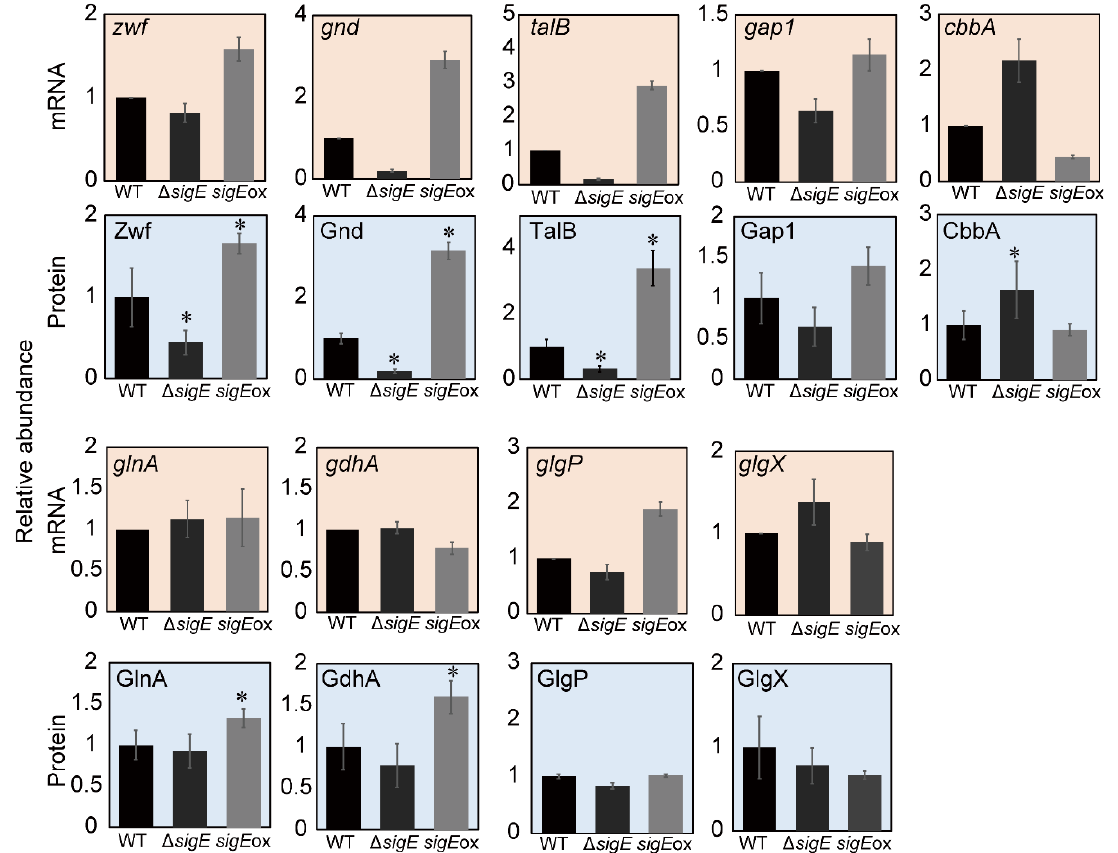
Figure 5. Comparison between gene expression and protein abundance in the wild-type (WT), Δ sigE , and sigE ox strains. The gene expression data obtained by the microarray analysis was obtained from a previous study [13]. Values are means ± standard deviation (SD) of three independent experiments. Asterisks indicate a significant difference assessed with two-sided Student’s t -test with an α level of 0.05.